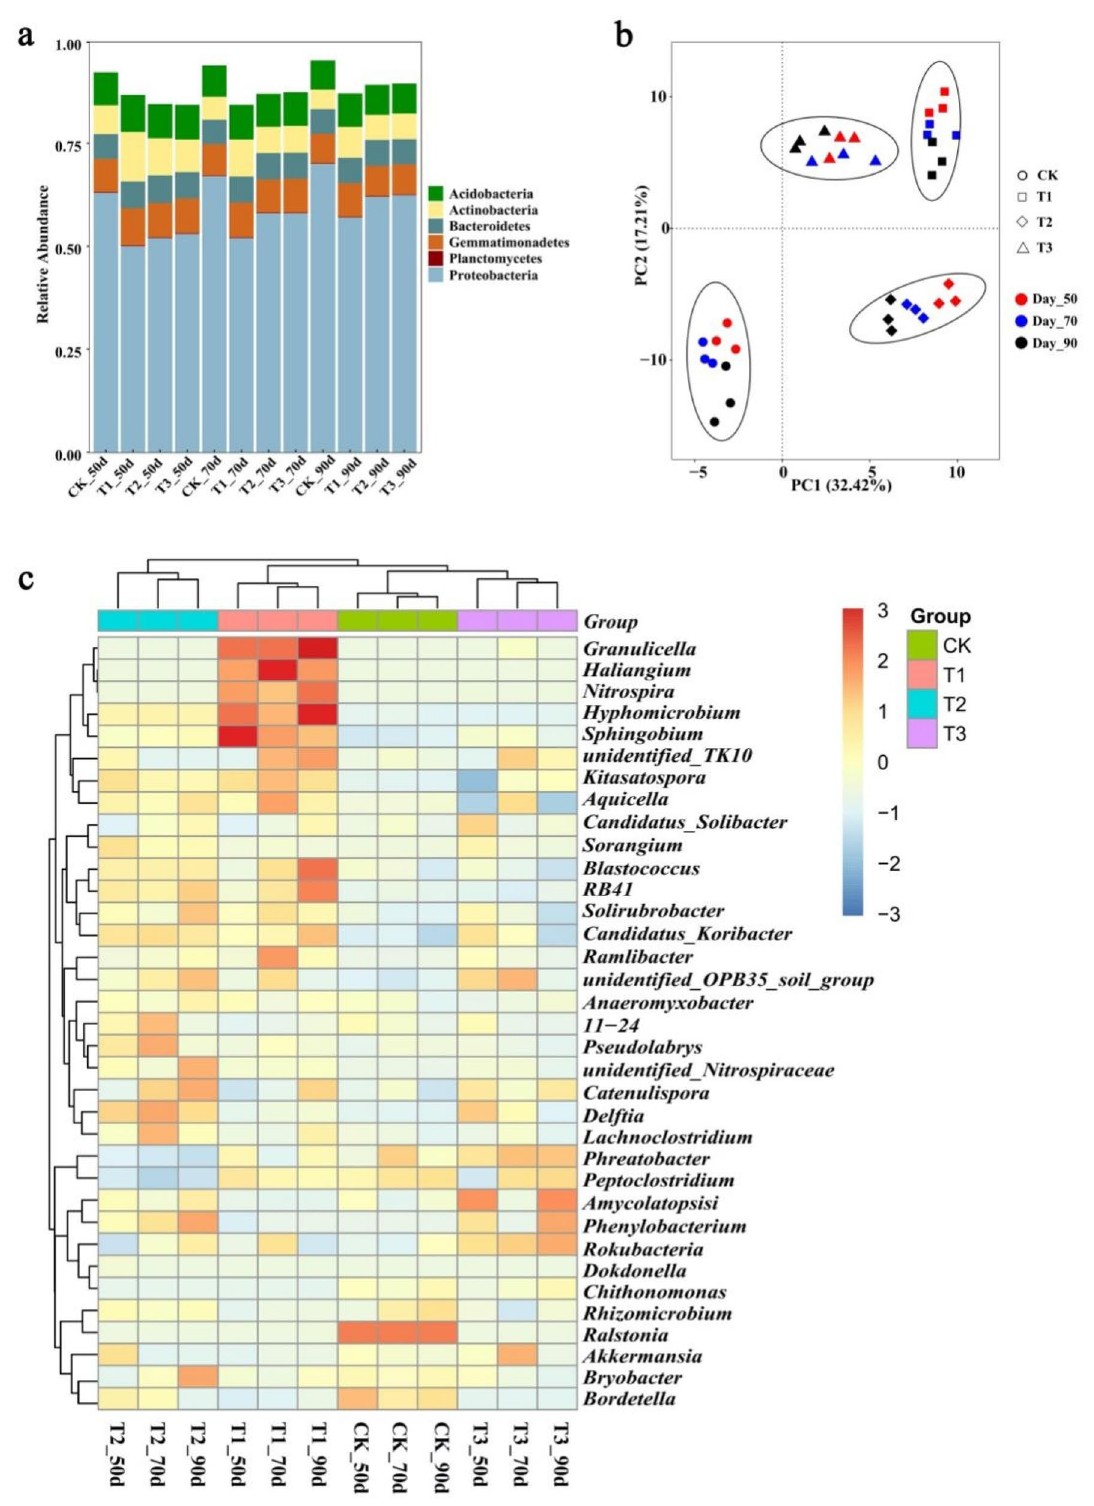
Figure 1. Soil bacterial community in four treatments at 50 days, 70 days and 90 days post-transplanted, respectively. (a) The relative abundance of bacterial phyla in soil samples. (b) The Principal components analyzed (PCA) of soil bacterial community. (c) Hierarchical cluster analysis of predominant bacterial genera. (CK: the control group, T1: marigold powder mix with B. amyloliquefaciens ZM9 group, T2: B. amyloliquefaciens ZM9 group, T3: marigold